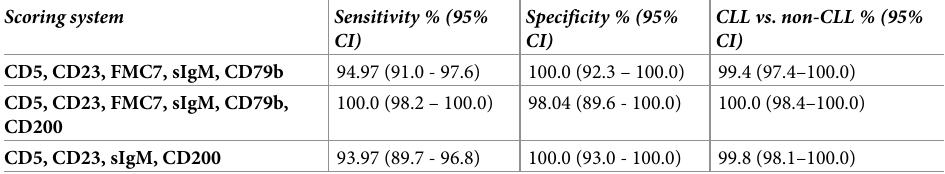
Table 5. Sensitivity, specificity, and accuracy of Matutes scoring systems CLL versus Non-CLL differential